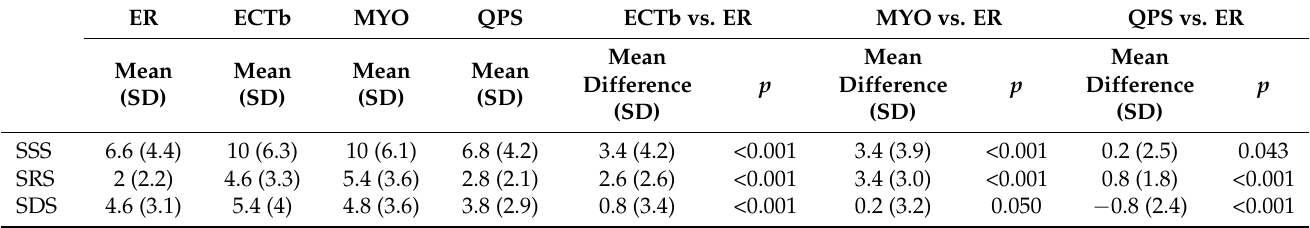
Table 2. SSS, SRS, SDS values for ER and ECTb, MYO, and QPS software packages.